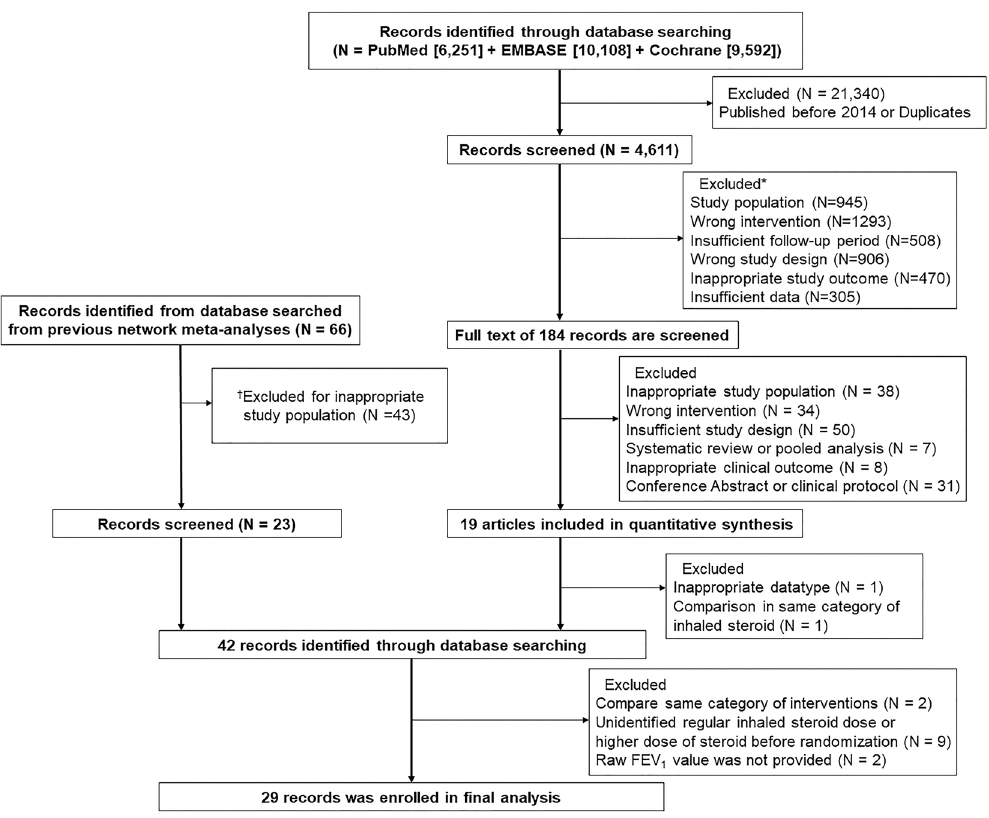
Figure 1. Study selection process. Asterisk: Records excluded in the screening of title, abstract. Dagger: Records excluded based on study population (mild and moderate